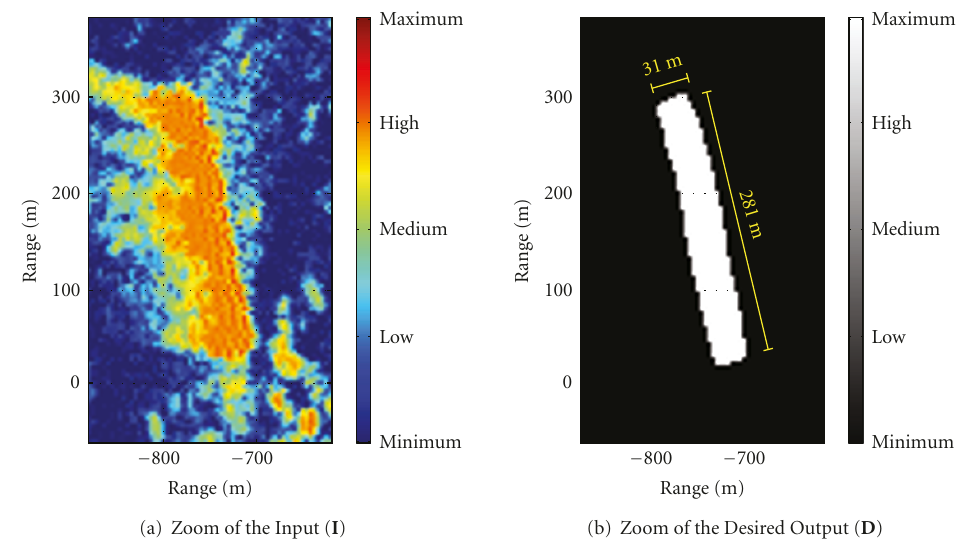
Figure 8: Zoom of the relevant area of the input ( I ) and desired output ( D ) Radar images of Figure 3.